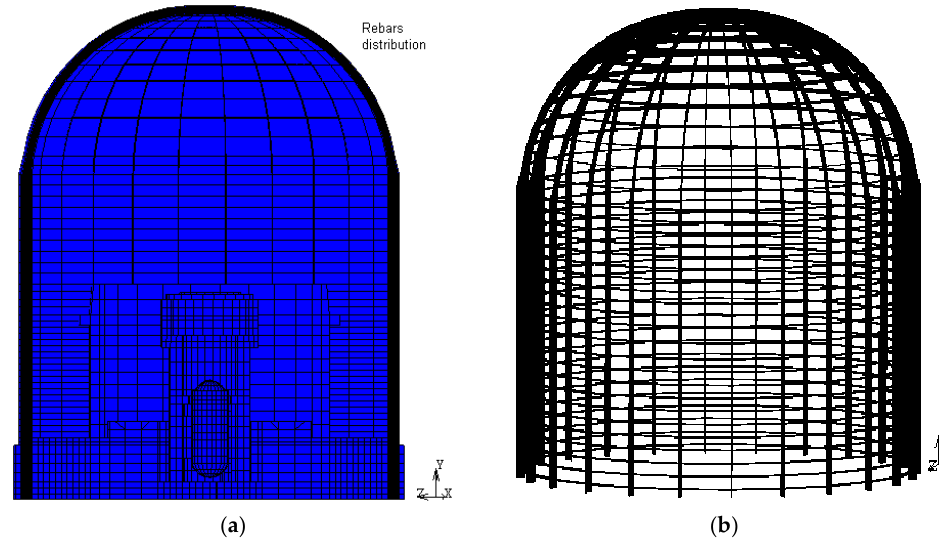
Figure 7. Vertical section of the CC model ( a ) and overview of the reinforcement arrangement ( b ).